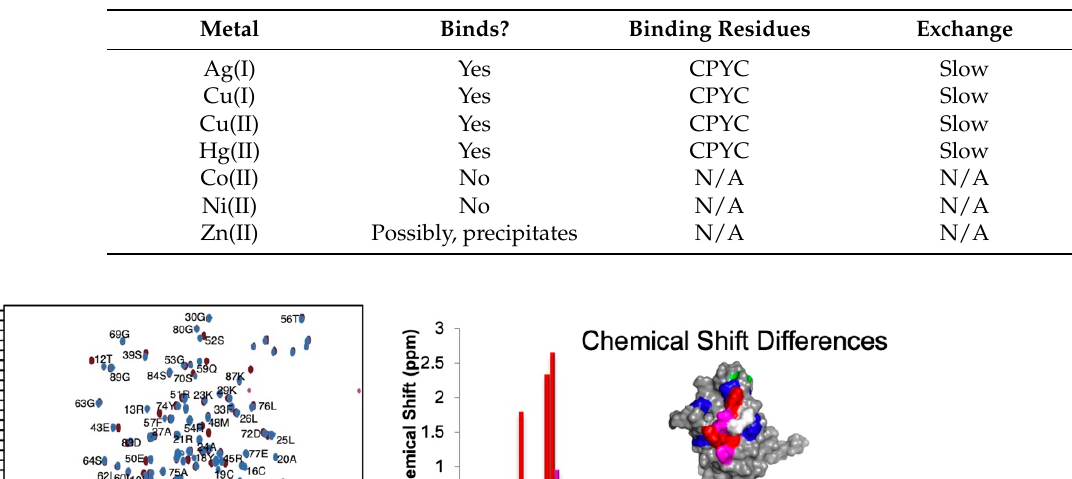
Table 1. Metals tested for GRX binding.